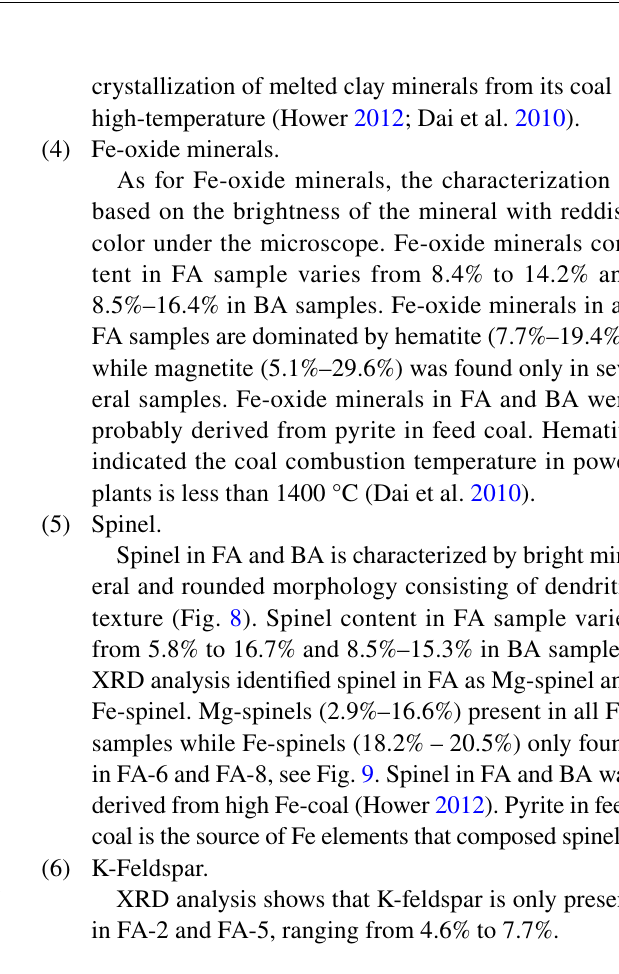
Table 5 Percentage of organic and inorganic components of BA samples based on petrographic analysis